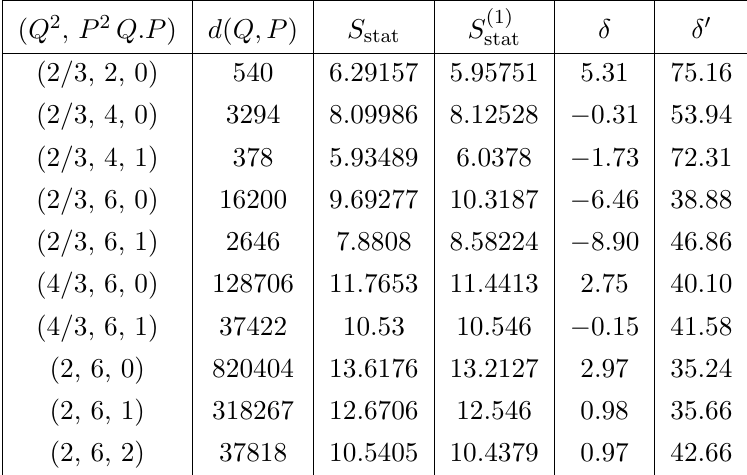
Table 6 . Comparison of the statistical entropy and statistical entropy at one loop for 3A orbifold.